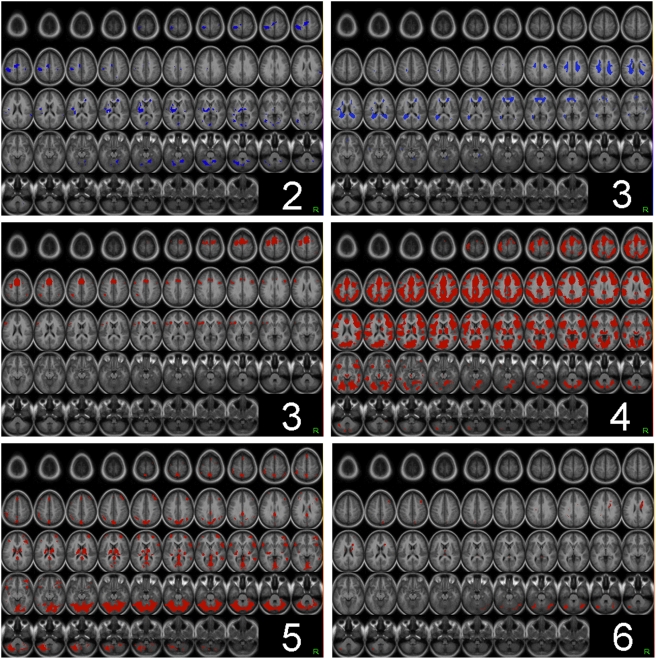
Timepoint-specific negative and positive correlations with RT.The white digit in each panel indicates the timepoint (i.e., the acquisition volume relative to trial onset) at which the correlation with RT occurred. Blue: negative correlations with RT in all five samples; red: positive correlations with RT in all five samples.